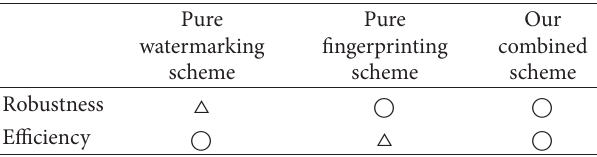
Table 6: Comparison of our combined scheme and the other two pure